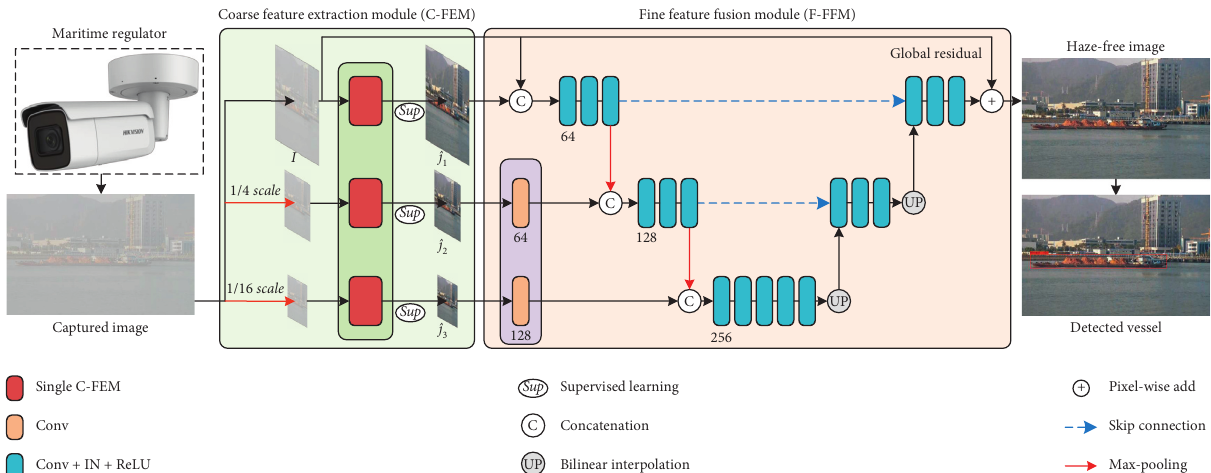
Figure 3: The flowchart of our method. From top to bottom in C-FEM: subimages reduced to 1, 1/4, and 1/16 of the original image, respectively.